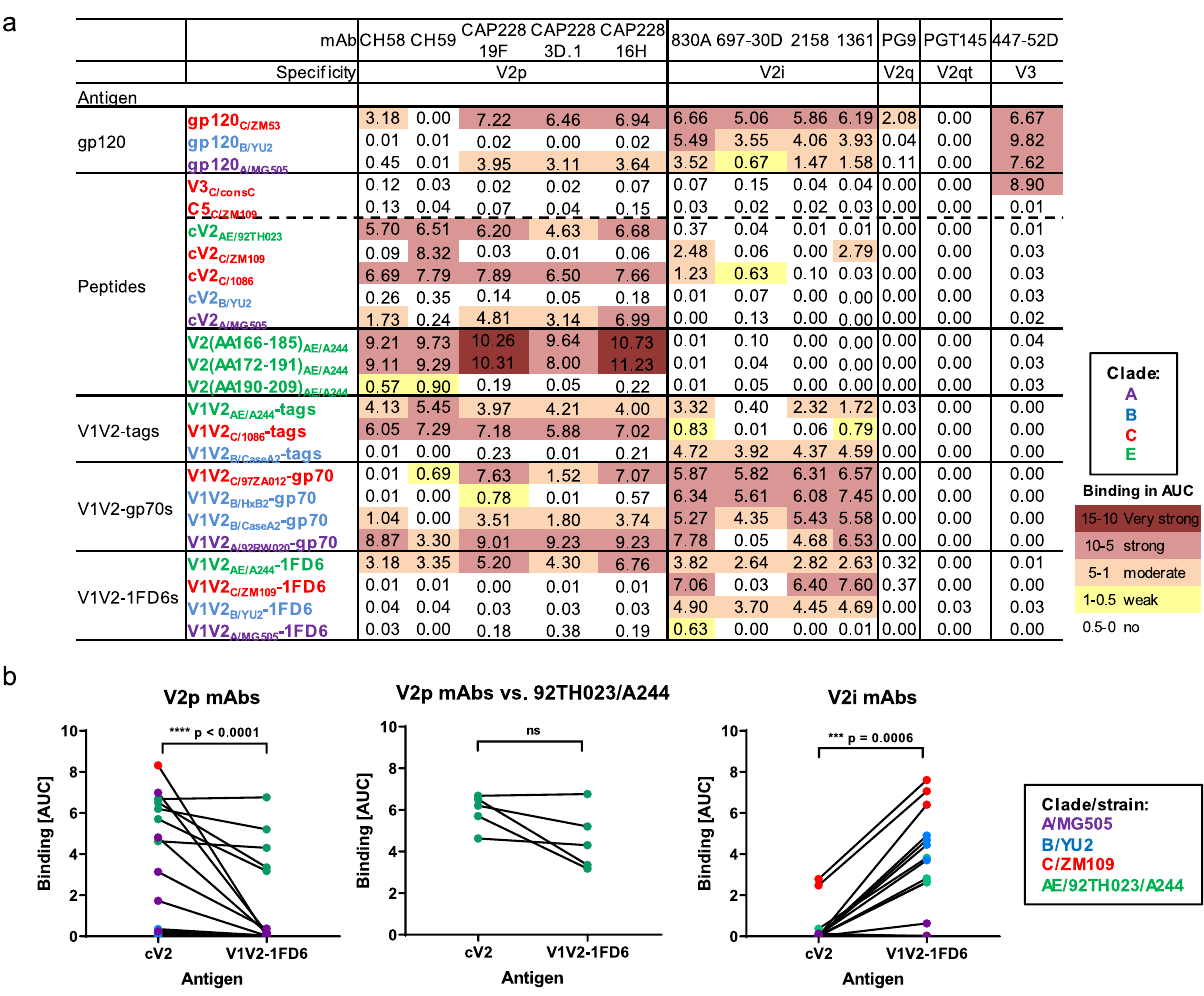
Fig. 1 Reactivity of HIV-1 Env antigens with V2 monoclonal antibodies. a A multiplex bead binding assay was used to determine the levels of reactivity of mAbs speci fi c for different V2 epitopes with various HIV-1 antigens. The clade from which each antigen was derived is indicated by the subscripted letter and by color coding. As a control, V3 mAb 447-52D was used. Irrelevant mAbs and PBS were used as negative controls in each experiment (not shown). Data are shown as AUC values generated from titration curves for each mAb, provided in Supplementary Fig. S1. Strength of binding is color-coded as per the spectrum shown in the fi gure. Experiments were performed at least twice. b Statistical analyses comparing binding to cV2 peptides and V1V2-1FD6 proteins by V2p mAbs (CH58, CH59, CAP228_19F, CAP228_3D.1, and CAP228_16H) ( p < 0.0001) (left graph) and V2i mAbs (830 A, 697-30D 2158, 1361) ( p = 0.0006) (right graph) are shown along with a comparison of V2p mAbs (CH58, CH59, CAP228_19F, CAP228_3D.1, and CAP228_16H) vs cV2 peptides and V1V2-1FD6 proteins derived from HIV AE/92TH023 and HIV AE/A244 ( p = 0.125) (center graph). Color of symbols show the clade/strain of the antigen used as per those used in Fig. 1a and Supplementary S2. Lines connect pairs of a given mAb with reagents from a given strain. For example, the connected red symbols in the left panel of Fig. 1b represent the reactivity of V2p mAb CH59 with cV2 C/ZM109 and V1V2 C/ZM109 -1FD6. Statistical analyses were performed with the two-tailed Wilcoxon matched-pairs signed-rank test and are shown for: all HIV-1 strains used in Figure1b (left and right graphs) or for V2p mAbs reacting to the HIV-1 strain A244 (middle graph). Source data are provided as a Source Data fi le. AA amino acid, Ab antibody, Ags antigens, AUC area-under-the-curve, consC consensus C, cV2 cyclic V2, Env envelope, mAb monoclonal